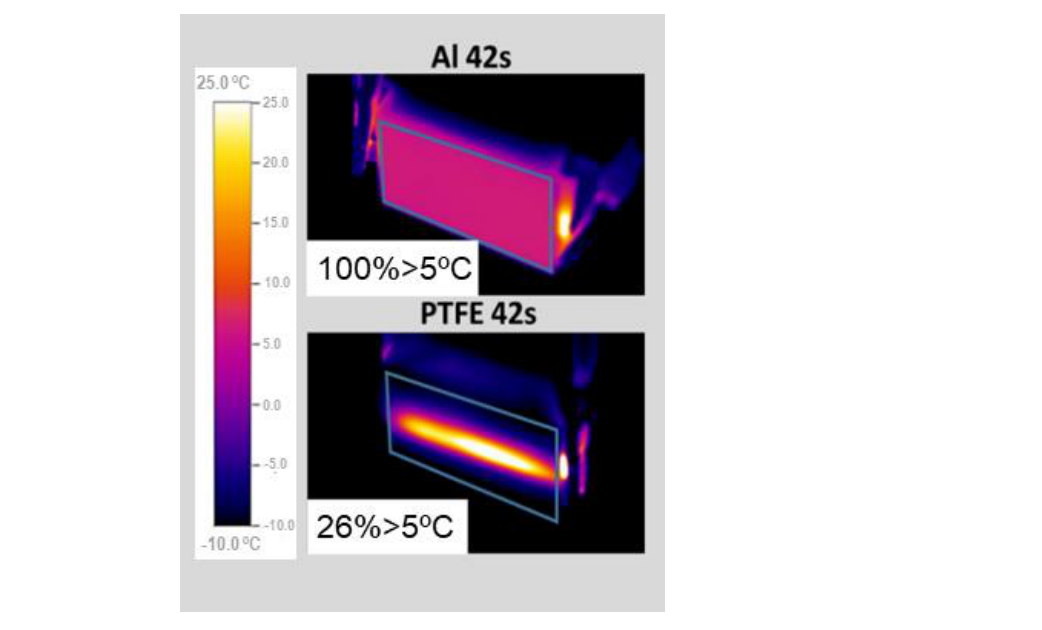
Figure 4. Images showing homogeneous heating AA6061 ( Top ) and heterogeneity of PTFE ( Bottom ).